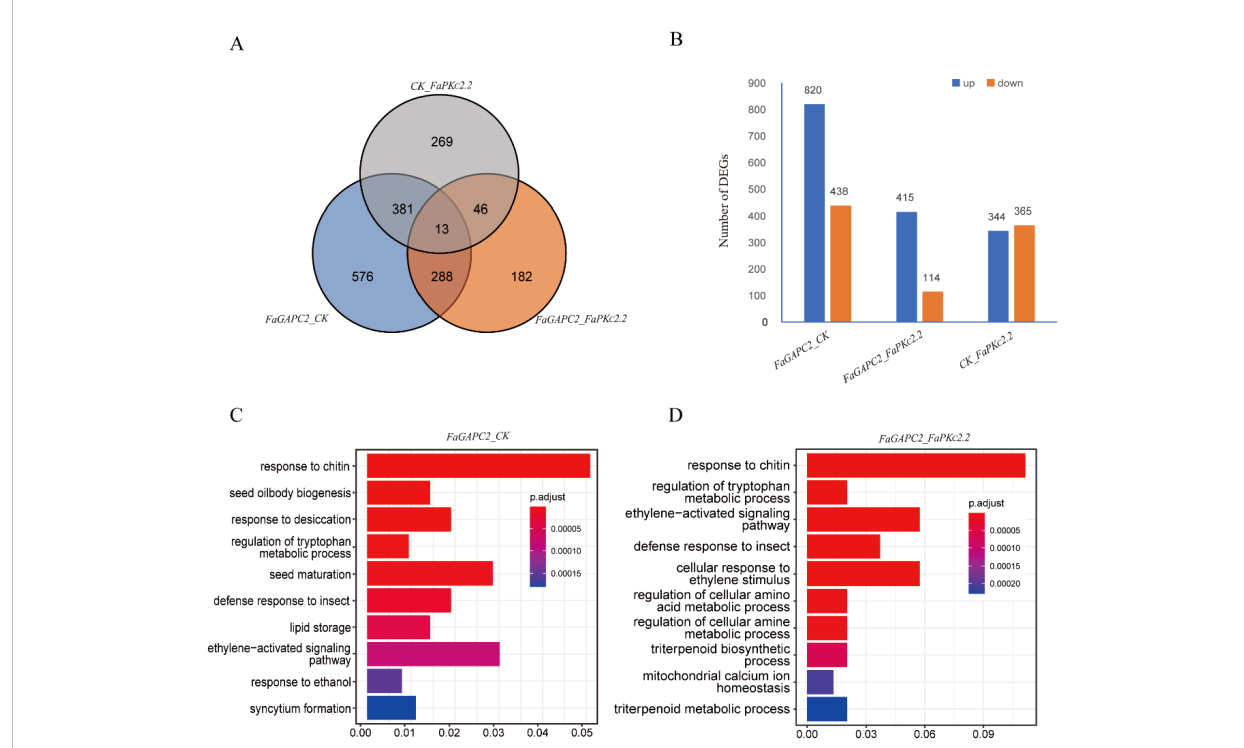
FIGURE 4 Analysis of DEGs in FaGAPC2 / FaPKc2.2 -overexpressed fruits. Total number of DEGs in FaGAPC2 / FaPKc2.2 -overexpressed fruits (A) , number of up- regulated and down-regulated DEGs in FaGAPC2 / FaPKc2.2 -overexpressed fruits (B) , GO enrichment analysis of DEGs between the FaGAPC2 - overexpressed fruits and CK fruits (C) , GO enrichment analysis of DEGs between the FaPKc2.2 -overexpressed fruits and CK fruits (D)